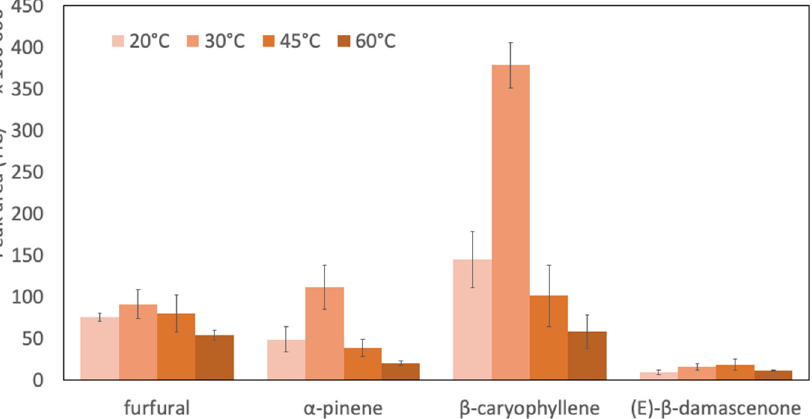
Figure 1. Impact of temperature on the peak area (TIC) with standard deviations of four selected compounds of the model mixture. ( n = 3).